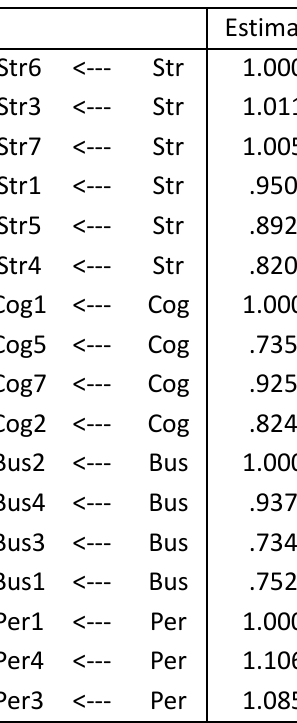
Table 2: Convergent Validity of CFA Test